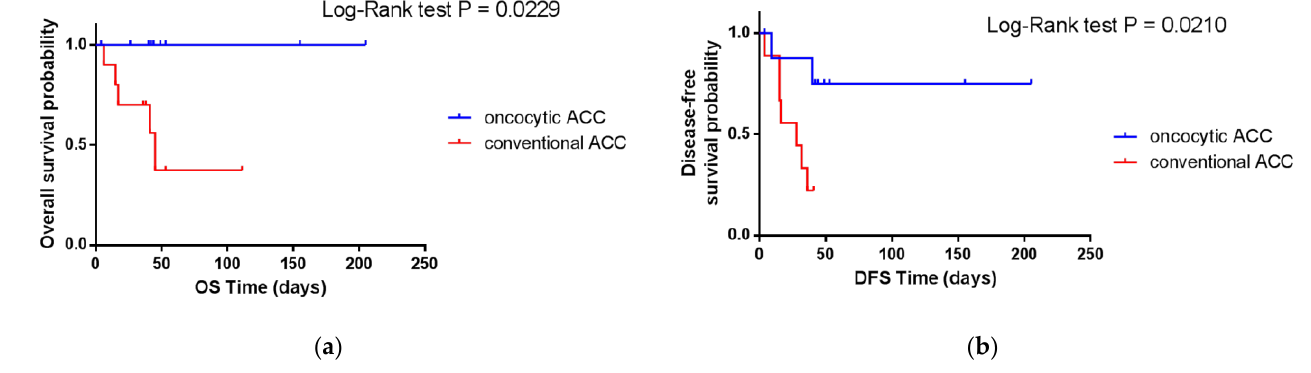
Figure 3. Overall ( a ) and disease-free ( b ) survival of conventional and oncocytic ACC patients from the ERC cohort.